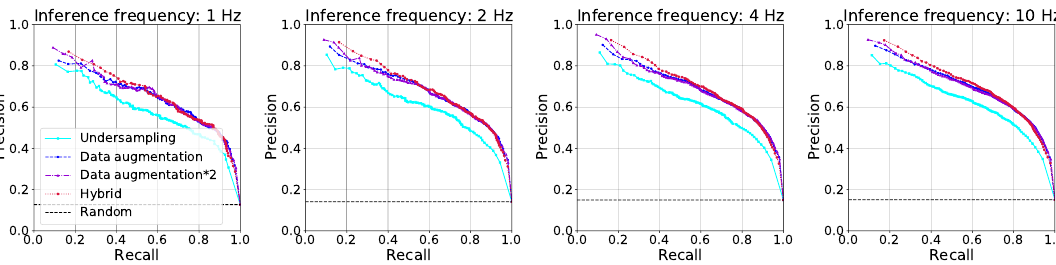
0.0 0.2 0.4 0.6 0.8